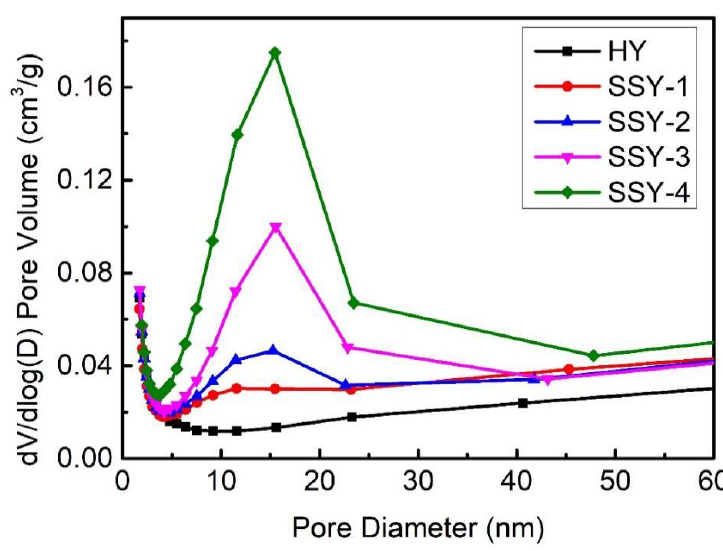
Figure 1. Nitrogen adsorption – desorption isotherms of the modified and parent zeolites.